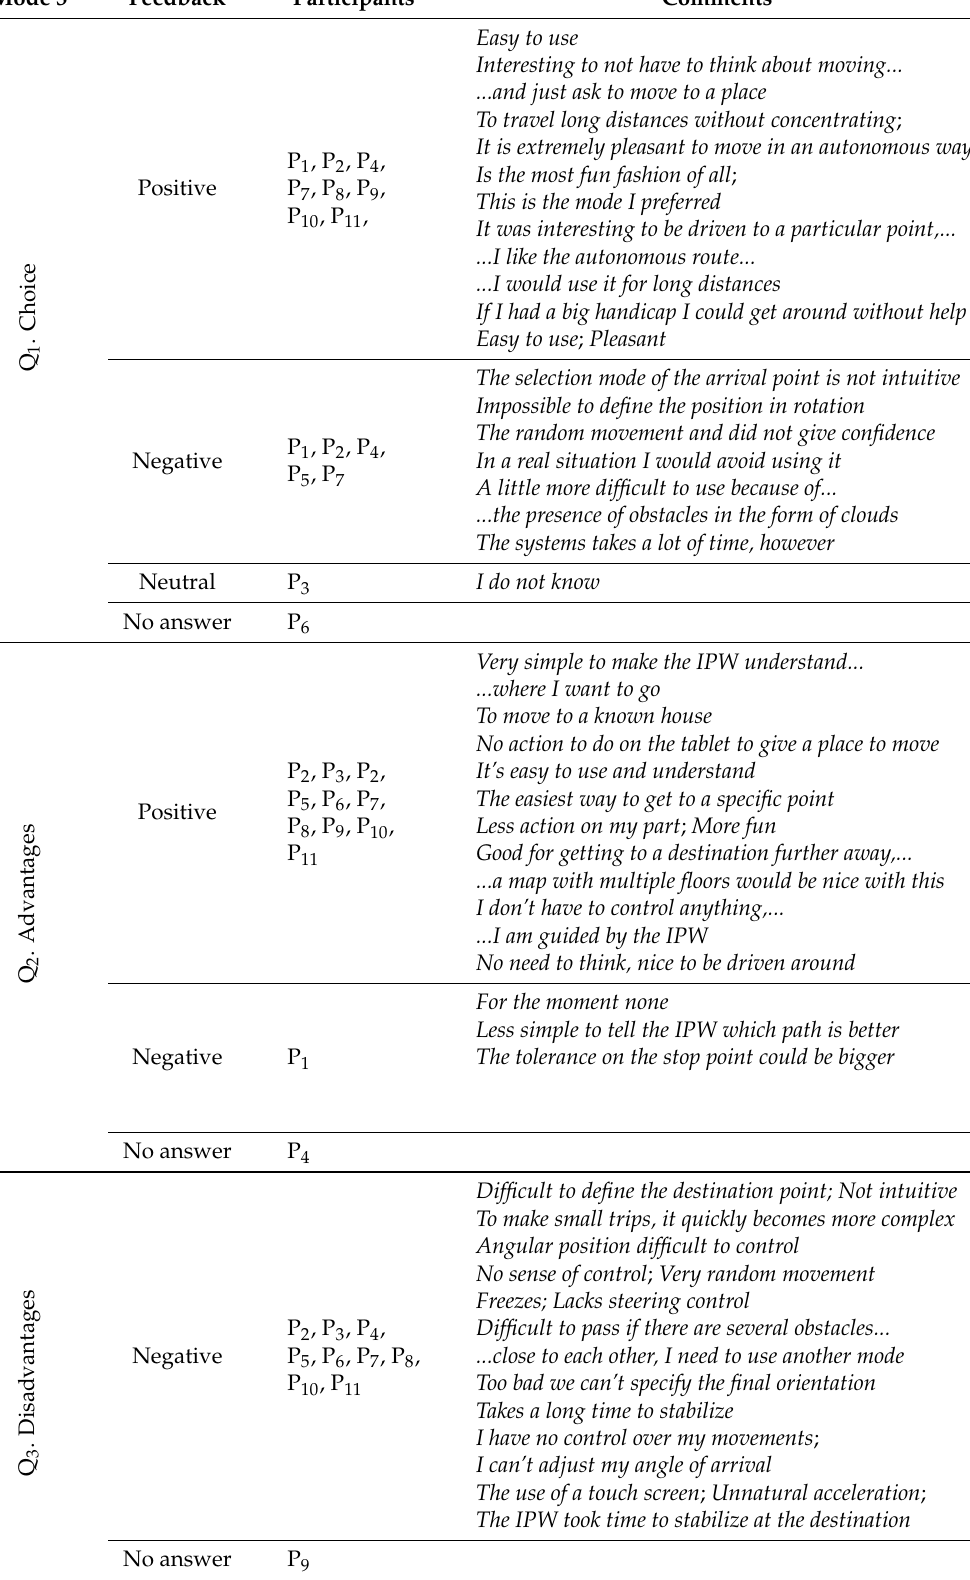
Table 5. Autonomous